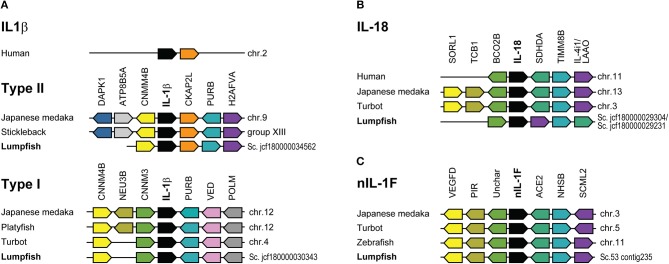
Synteny analysis of IL-1 ligands. (A) Human IL-1β locus and IL-1β type I and II in selected fish species. (B) IL-18. (C) nIL-1F. Schematic diagrams showing the genomic regions containing the IL-1 ligands. Lumpfish sequences are compared with Japanese medaka, stickleback, turbot, zebrafish, platyfish, and human. Conserved genes in the IL-1β and IL-18 locus in humans are shown for comparison. The IL-1 family ligands are shown in black boxes. Identical genes have same color.